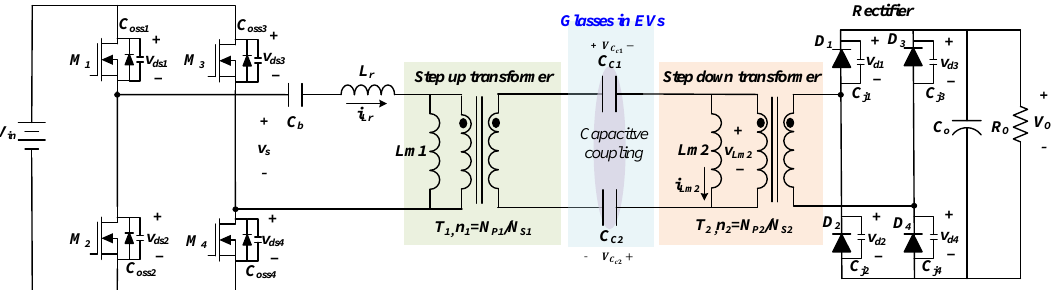
Figure 4. Proposed quasi-LLC resonant CCWPT power conversion circuit.